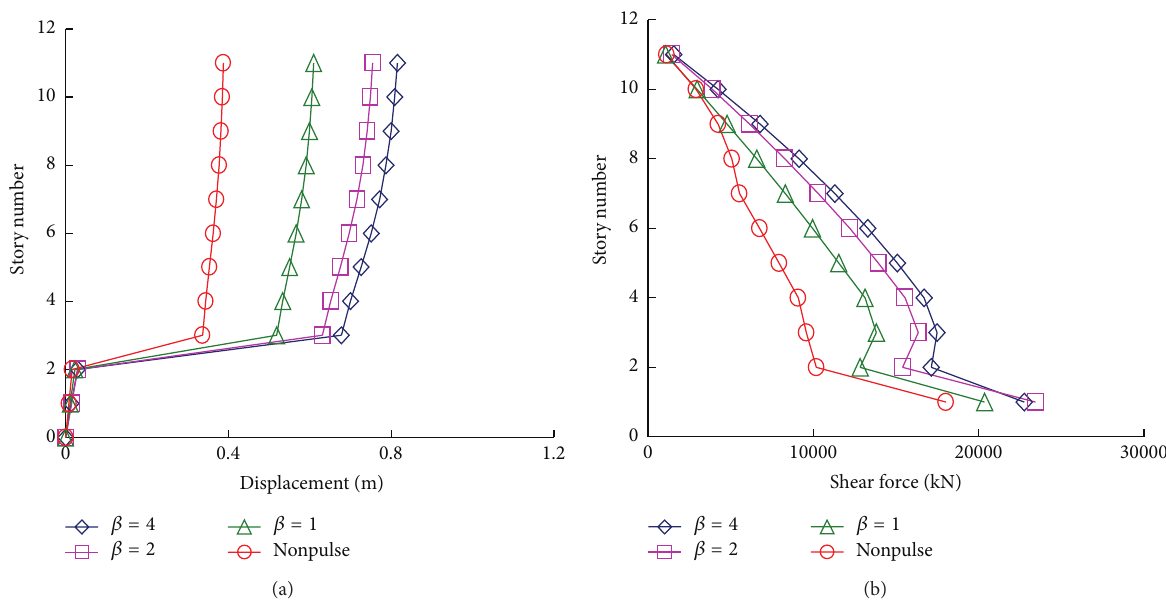
Figure 8: Effects of pulse contributing factor 𝛽 on dynamic responses of the midstory isolated structure. (a) Peak displacement along height of building; (b) peak shear force along height of building.